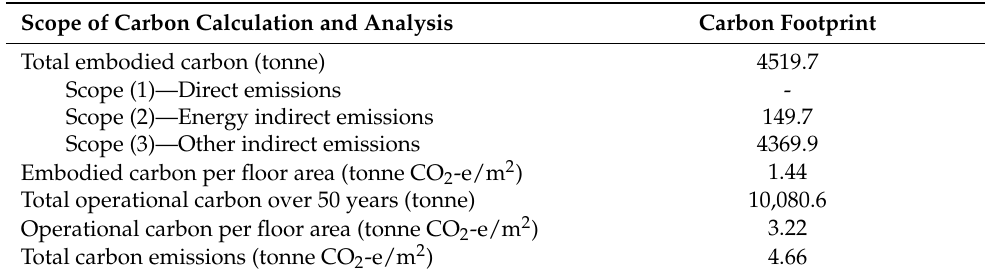
Table 6. Lifecycle carbon emissions for the residential building.